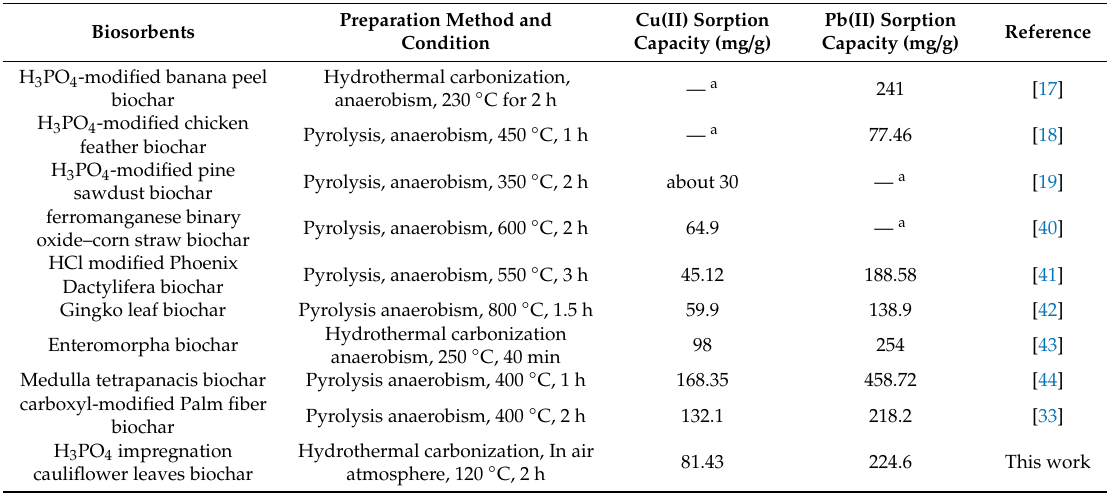
Table 3. Comparisonof Cu(II) and Pb(II) adsorption capacity of CLB with other biochars.